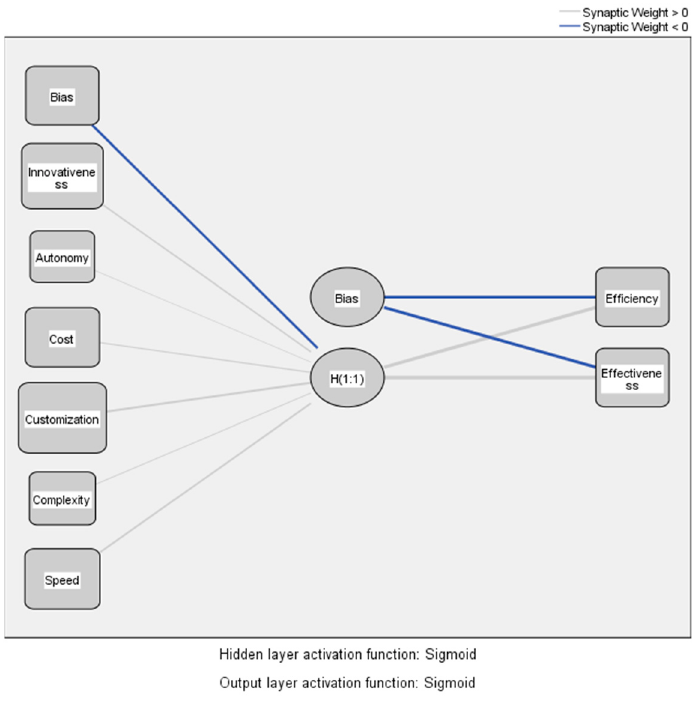
Figure 3. Multilayer perceptron for digital transformation in project management. Source: author’s design using SPSS v.20.